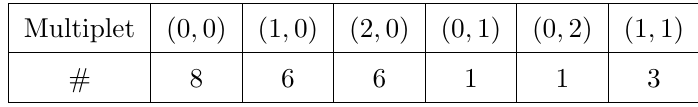
Table 5 . Number of scalar double-trace multiplets with ^(cid:1) =